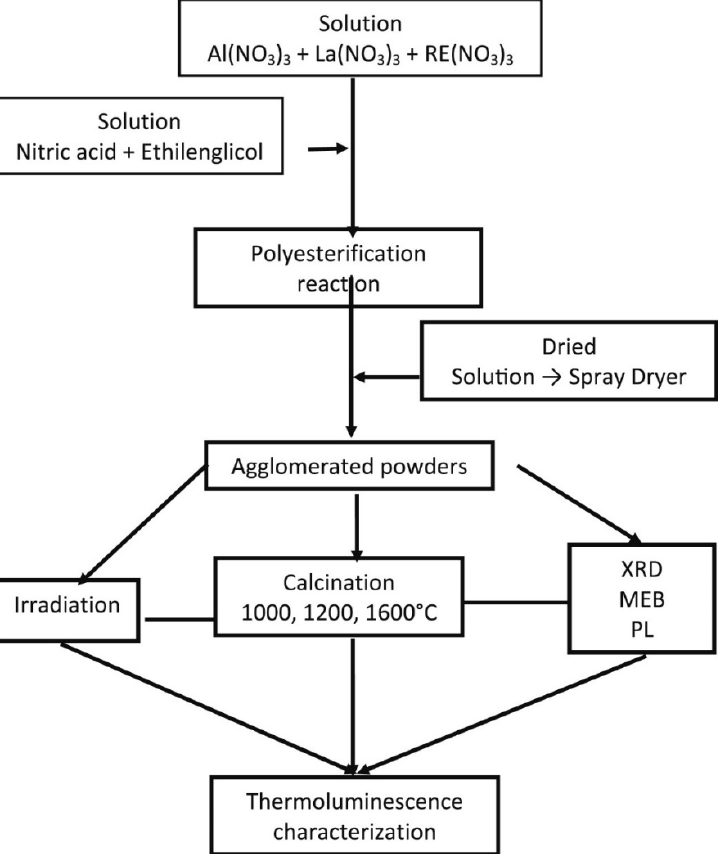
Figure 19. Flowchart for preparing LaAlO 3 :RE using the modified Pechini method (Reprinted with permission from [97]).